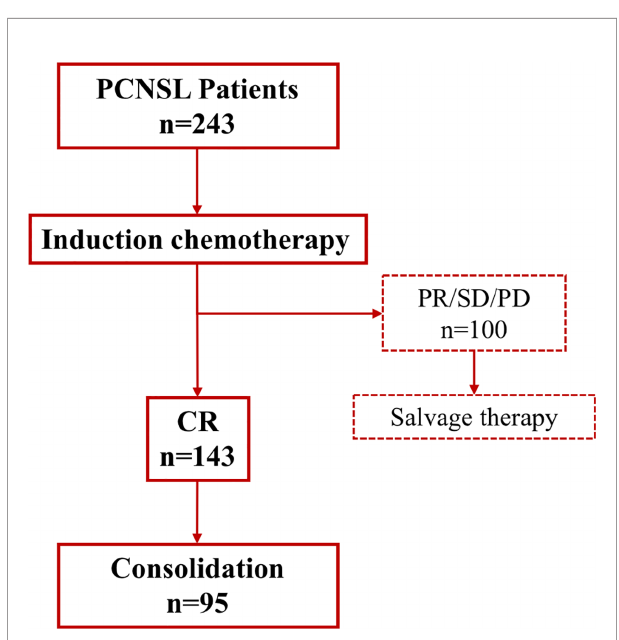
FIGURE 2 | Response of induction and salvage treatment. CR, complete response; PR, partial response; PD, progressive disease; SD, stable